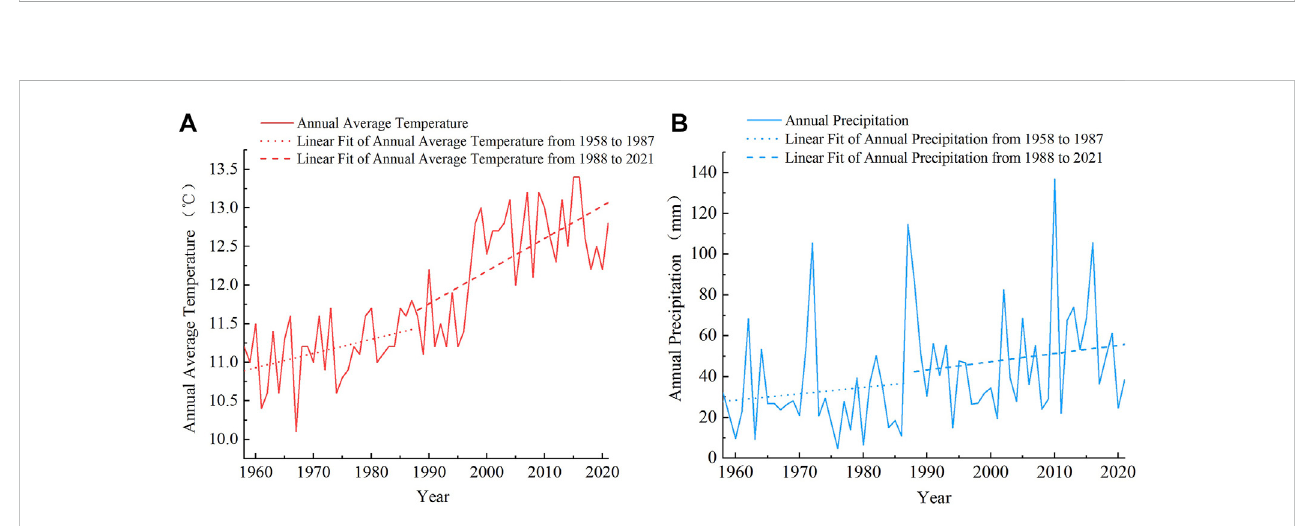
FIGURE 6 Annual variation characteristics and piecewise fi ttings of the temperature and precipitation in the basin. (A) Temperature. (B)